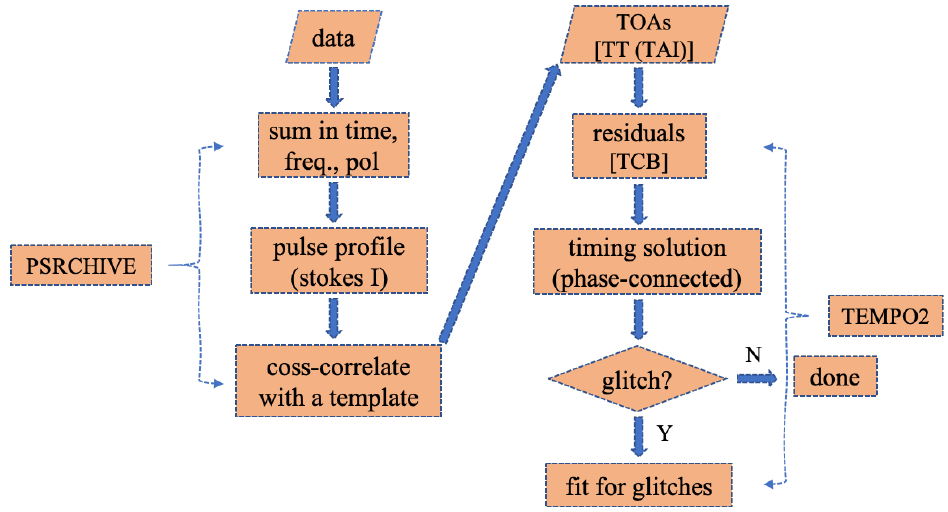
Figure 2. The most commonly employed data reduction routine for radio pulsar